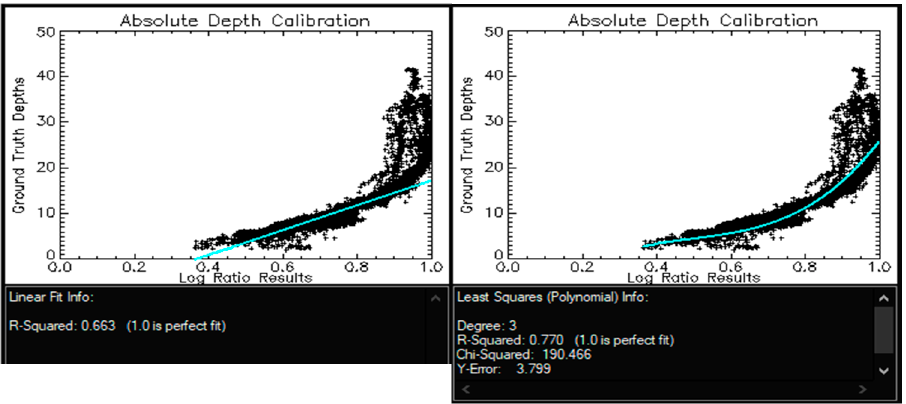
Figure A6. From 19 October 2013.